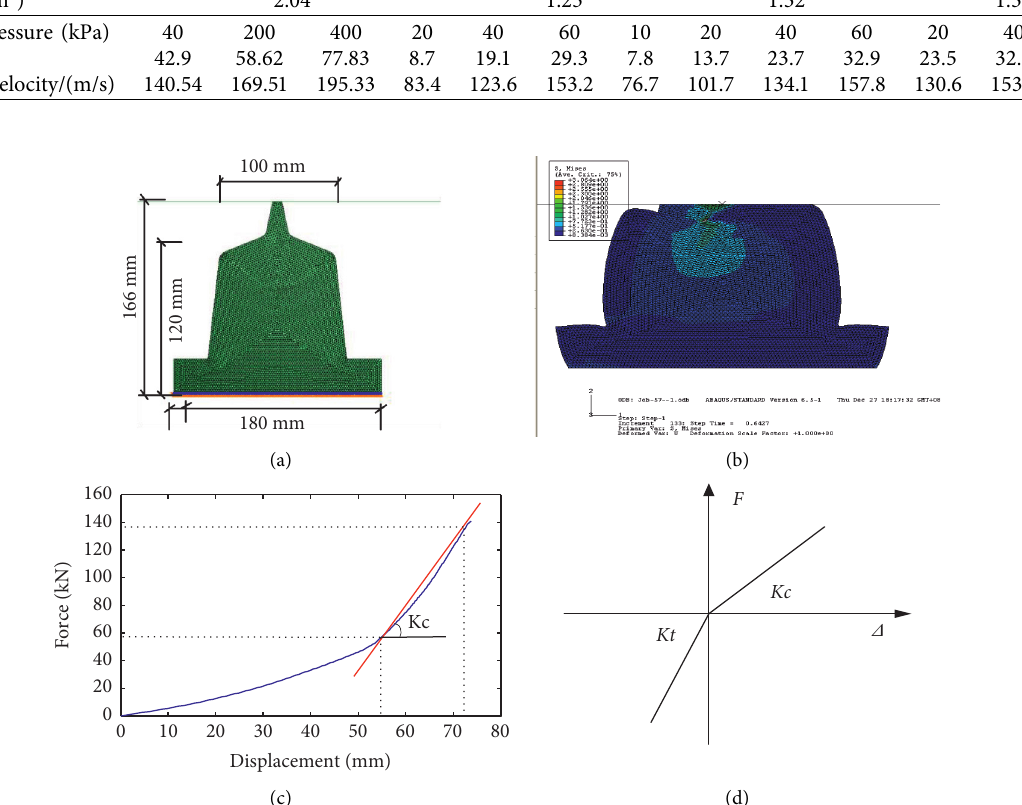
Table 3: Shear wave velocities of prototype soil and different proportions of sawdust soil. Undisturbed soil Sawdust soil 1: 2.5